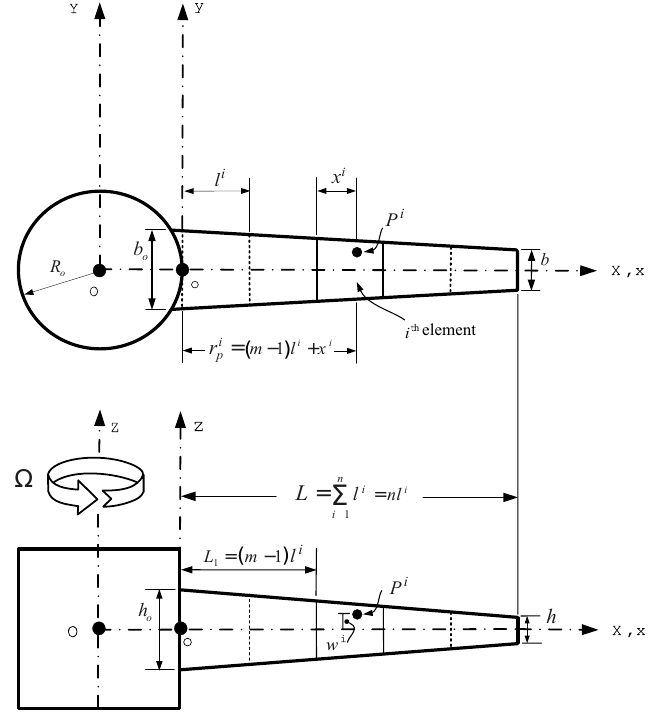
Fig. 1. Rotating cantilever beam linearly tapered in breadth and